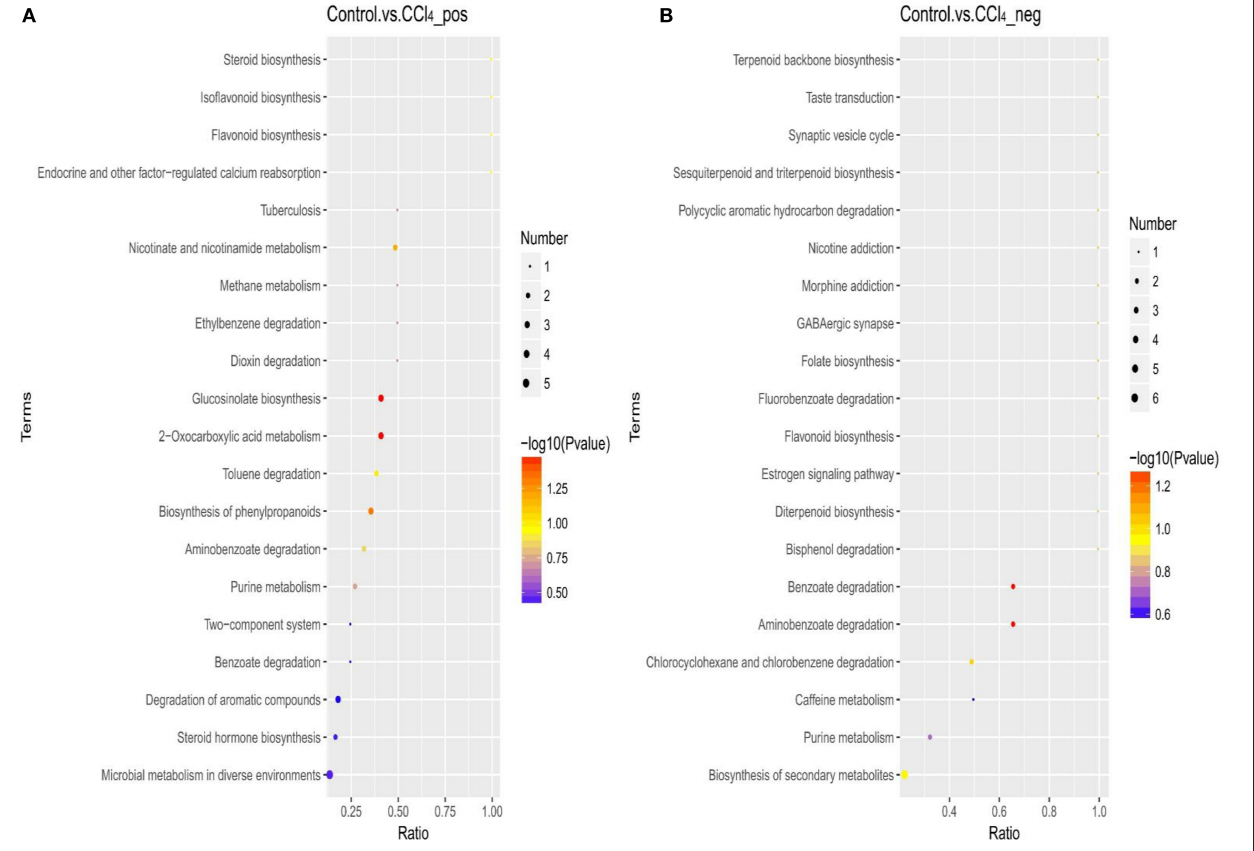
FIGURE 11 | Bubble plots for identification of the most relevant metabolic pathways between the control and CCl 4 groups under the positive (A) and negative (B) ion